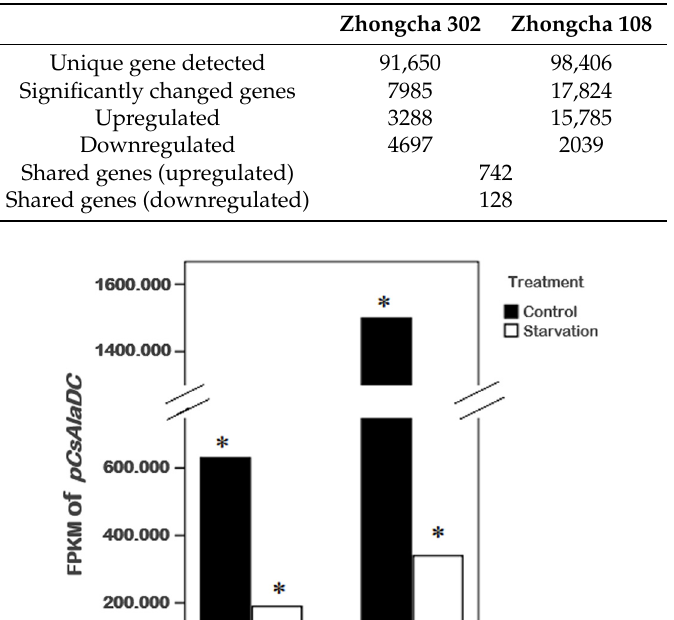
Table 1. Summary of messenger RNA (mRNA) detected under nitrogen starvation conditions.